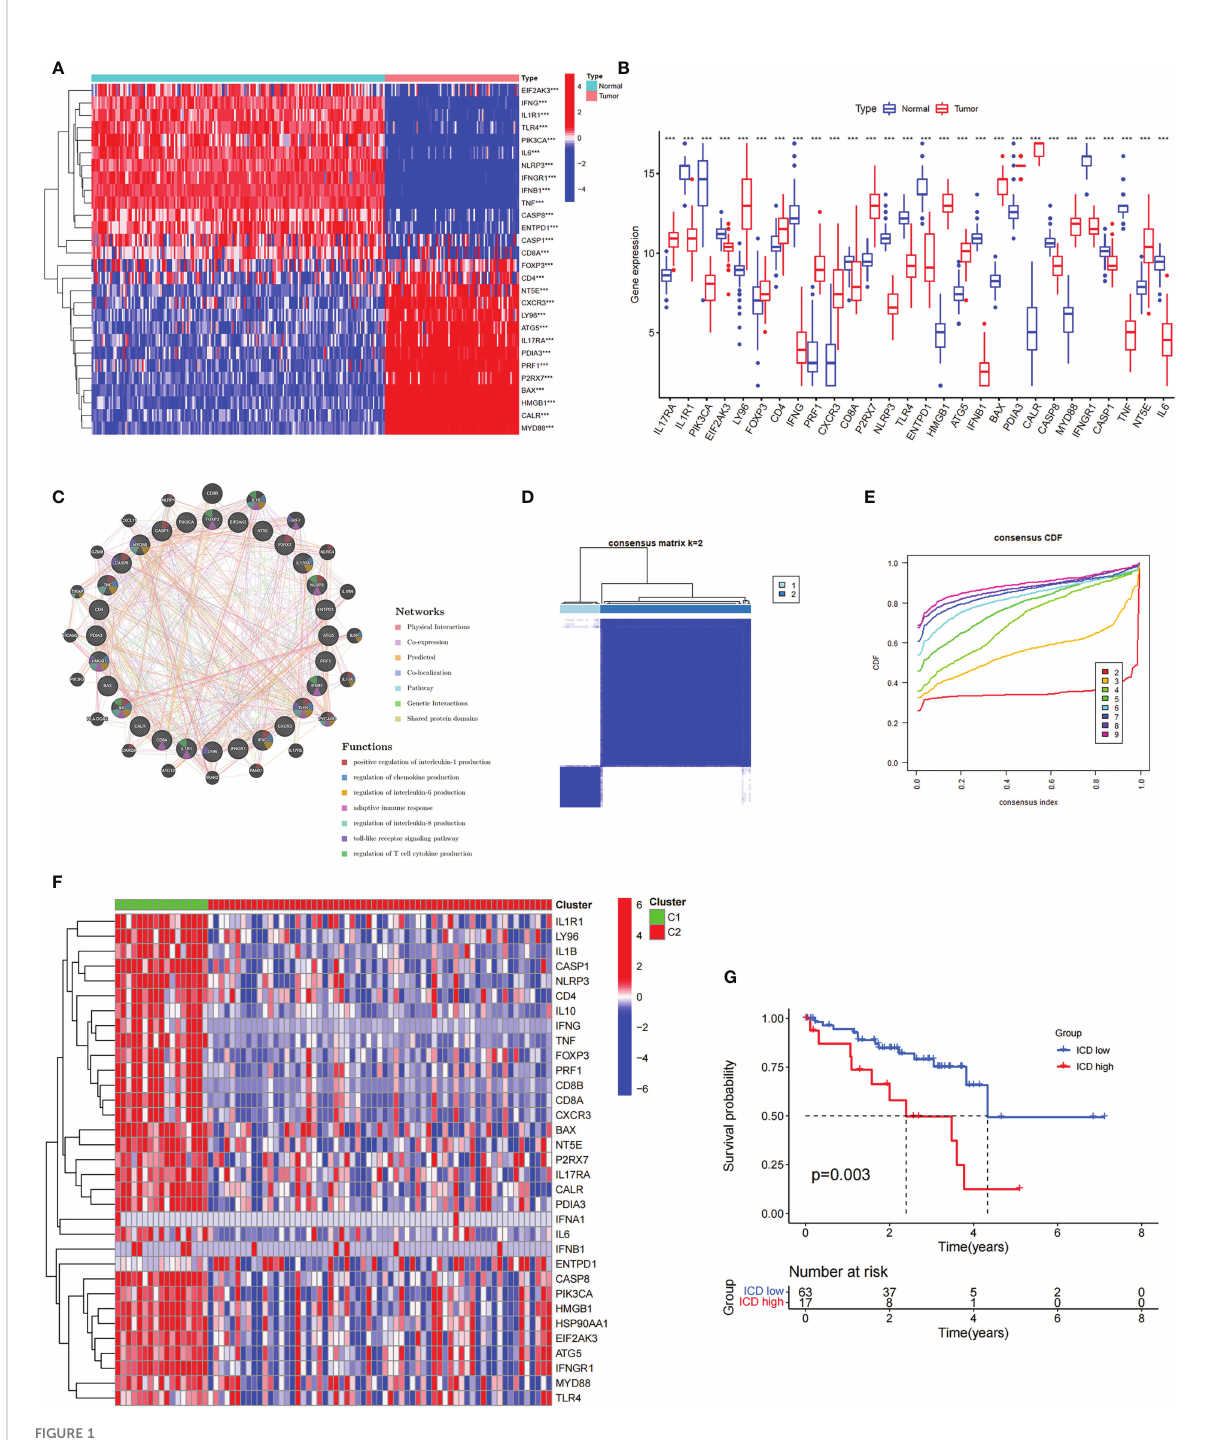
FIGURE 1 The expression pro fi les and the cluster of ICD-related genes in uveal melanoma. (A, B) The heatmap (A) and box plot (B) show that the expression patterns of 28 of the 34 ICD-related genes differed signi fi cantly between normal and UM samples in TCGA and GEO databases, ***P < 0.001. (C) Analysis of differentially expressed genes and their co-expressed genes by GeneMANIA. (D) Heatmap of consensus clustering solution (k = 2) for ICD-related genes in 80 UM samples. (E) The cumulative distribution function (CDF) curve of consensus clustering for k = 2 to 10. (F) Heatmap of ICD-related gene expressions in different subtypes. Green represents the high expression group and red represents the low expression group. (G) Kaplan – Meier curves of OS in the high and low ICD expression